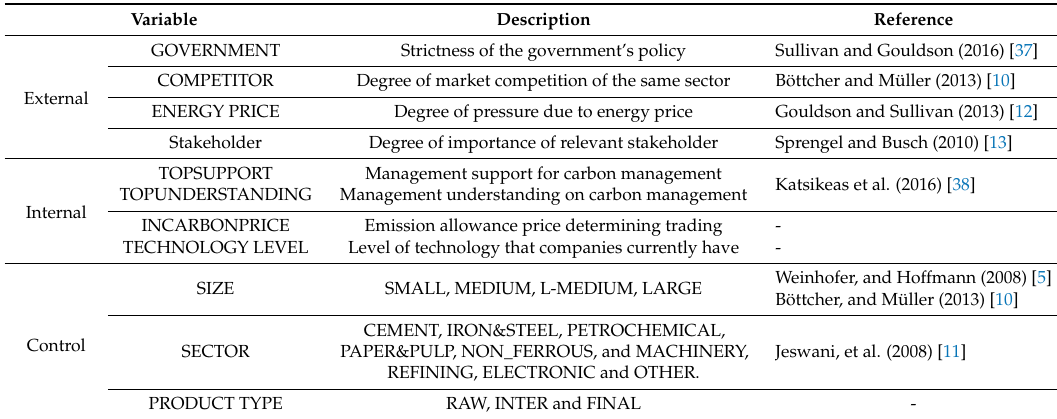
Table 2. Summary of